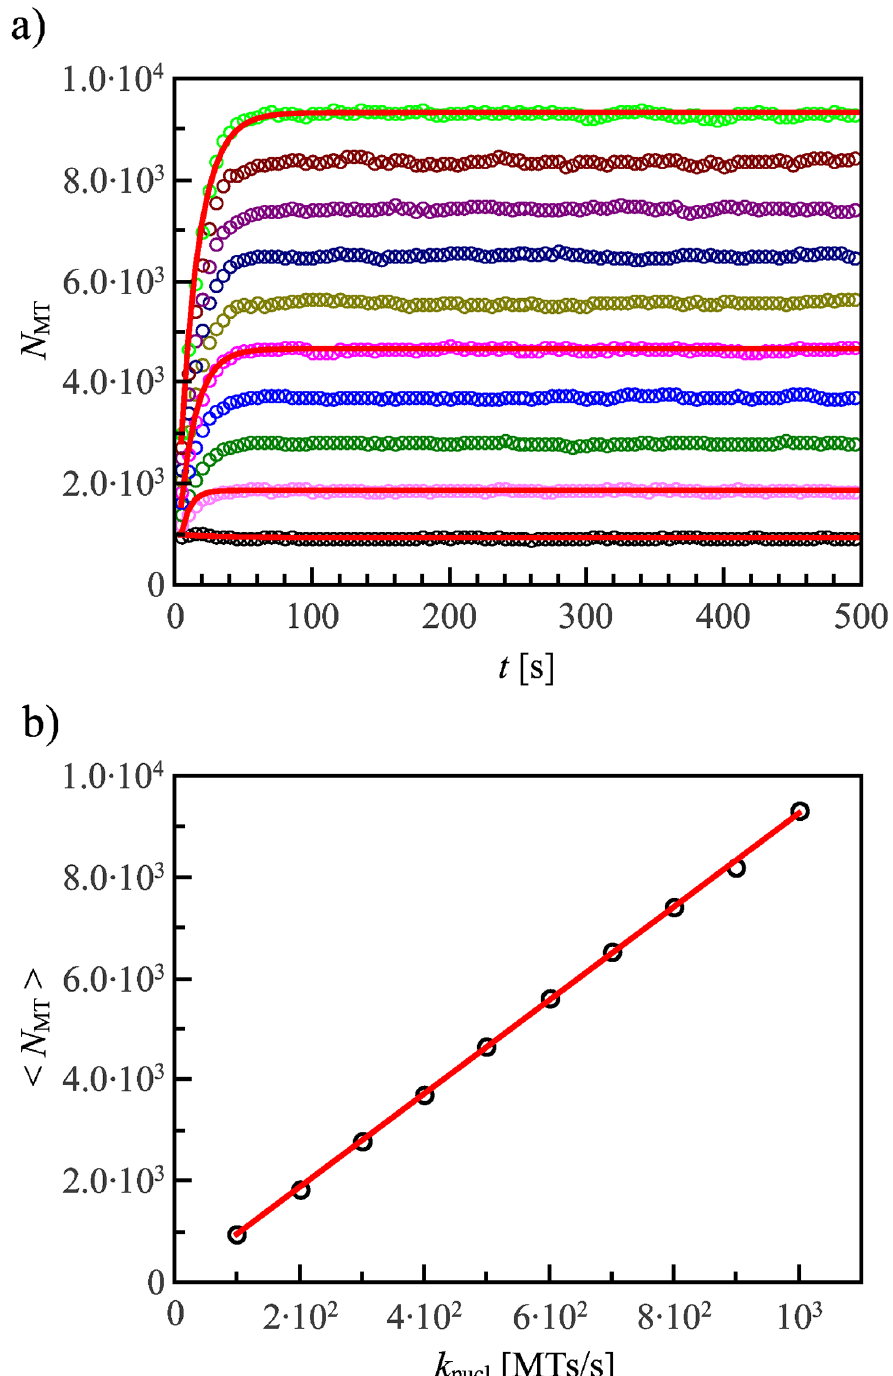
Fig 3. The rate of microtubule nucleation controls their number. (a) The number of MTs reaches a constant value in a time that is much shorter than the typical congression time. Different curves refer to different values of k nucl . (b) The number of MTs is proportional to the rate of nucleation k nucl . The numerical results here refer to a single pole. Lines are fits with the theory discussed in the text. The curves have been obtained by averaging over n = 1000 independent runs of the simulations. Error bars are smaller than the plotted